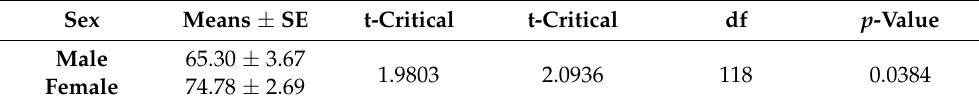
Table 2. Mean development days required for male and female Megachile cephalotes .